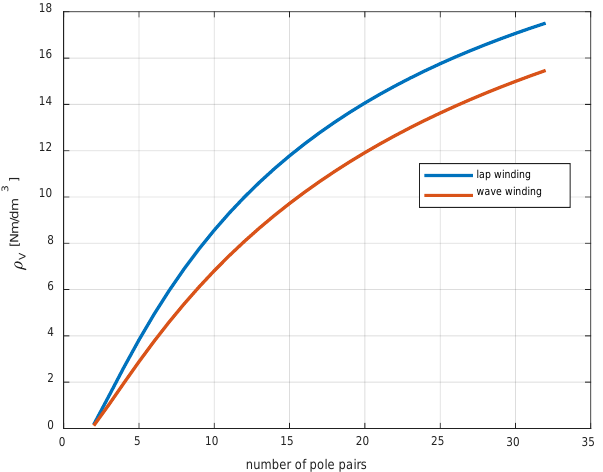
Figure 13. The torque-to-volume ratio as a function of the number of pole pairs for lap and wave windings.